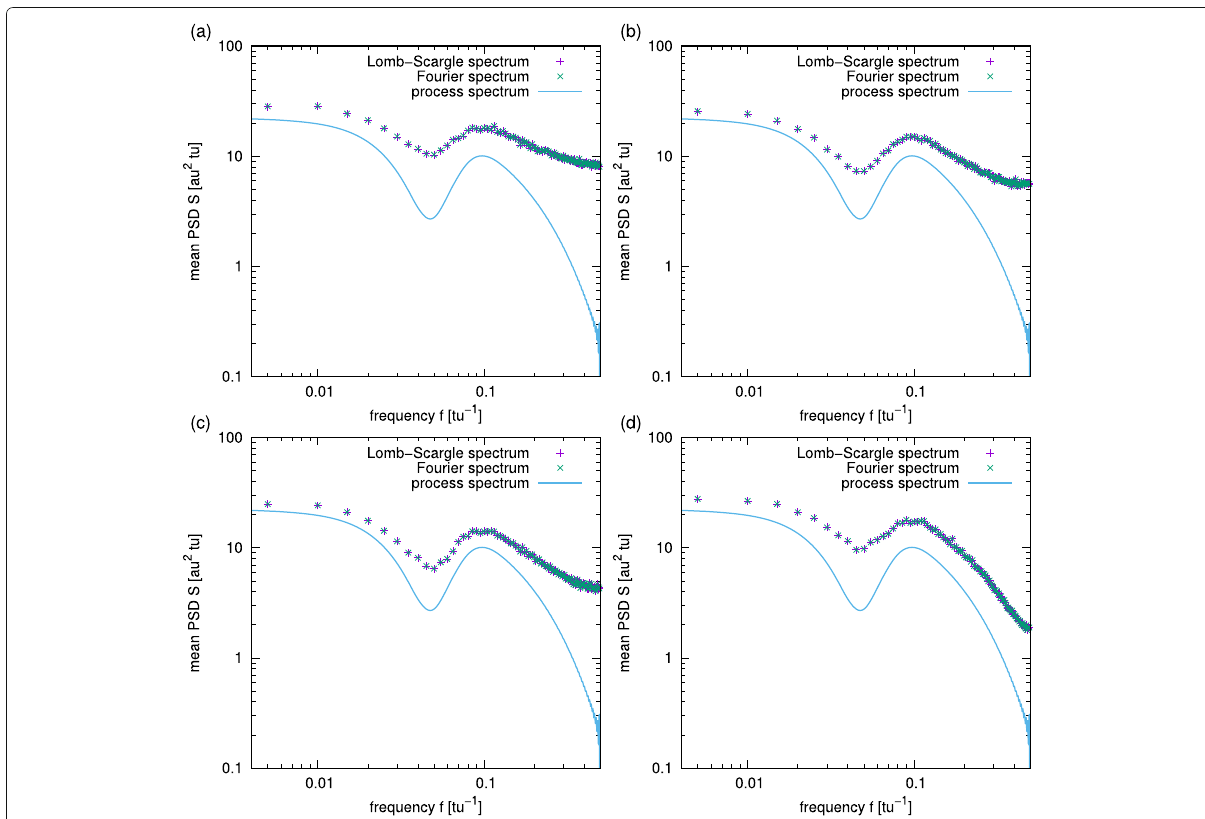
Fig. 4 Mean of the primary estimates (no correction) of the power spectral density from 1000 signals. a Ideal random and independent samples from continuous time with a continuous distribution of sampling intervals, b random samples from continuous time with a continuous distribution of sampling intervals with processor dead time, c independent outliers in equidistant time with a discrete distribution of sampling intervals, and d correlated data gaps in equidistant time with a discrete distribution of sampling intervals (au, amplitude unit; tu, time